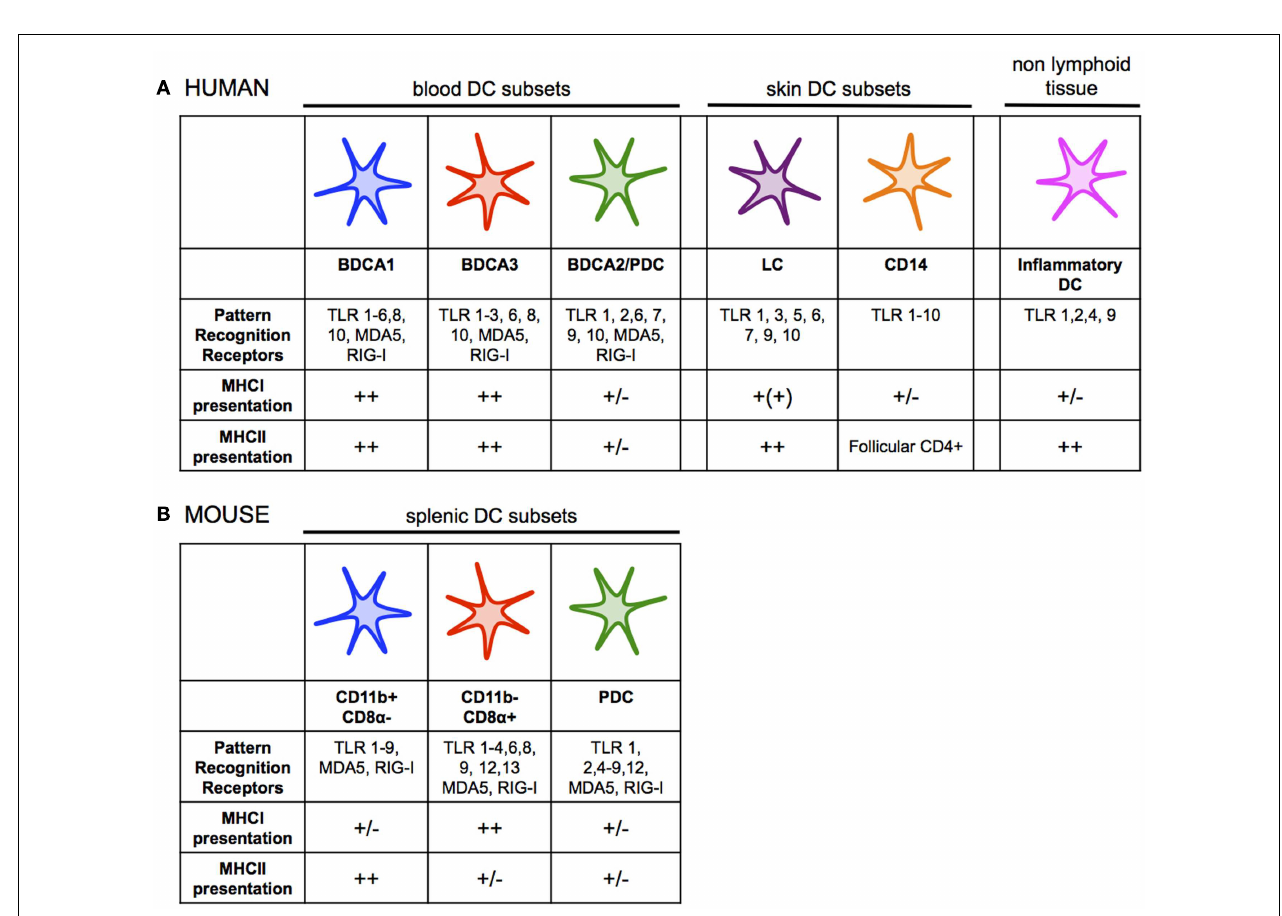
(B) A clear division of labor exists among mouse splenic dendritic cell subsets. CD11b − CD8 α + DCs are far superior and essential at priming CD8 + T-cell responses, while CD11b + DCs are specialized for presenting antigen on MHCII to stimulate helperT-cell immunity. pDCs can present antigen to CD4 + and CD8 + T cells, but likely their primary role in the immune response is the production of type I interferon during viral infection like their human counterparts.There is overlap between expression of PRRs among DC subsets, although CD11b − CD8 α + DCs express much higher levels ofTLR3 while CD11b + DCs uniquely express TLR5 andTLR7 (30, 35, 41, 58, 64,